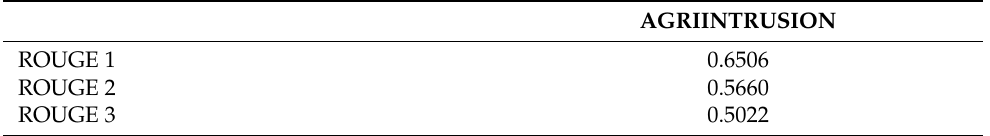
Table 4. ROUGE scores for the multitask DL framework for the AGRIINTRUSION